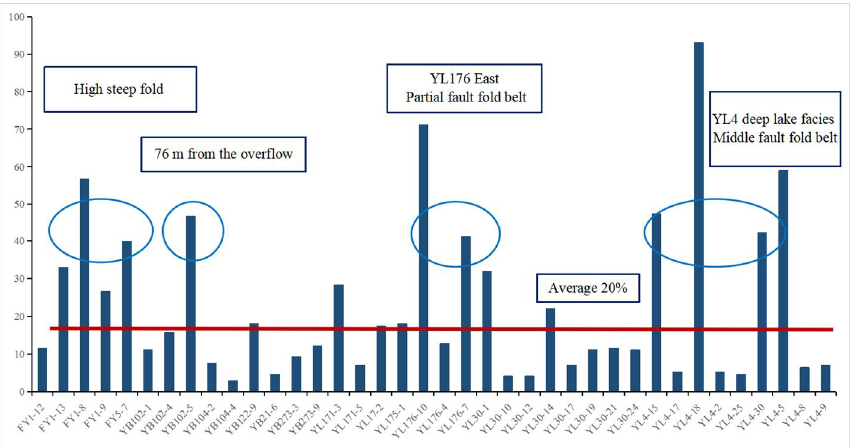
Figure 13. Relationship between the contribution of microfracture porosity and the degree of regional tectonic development.